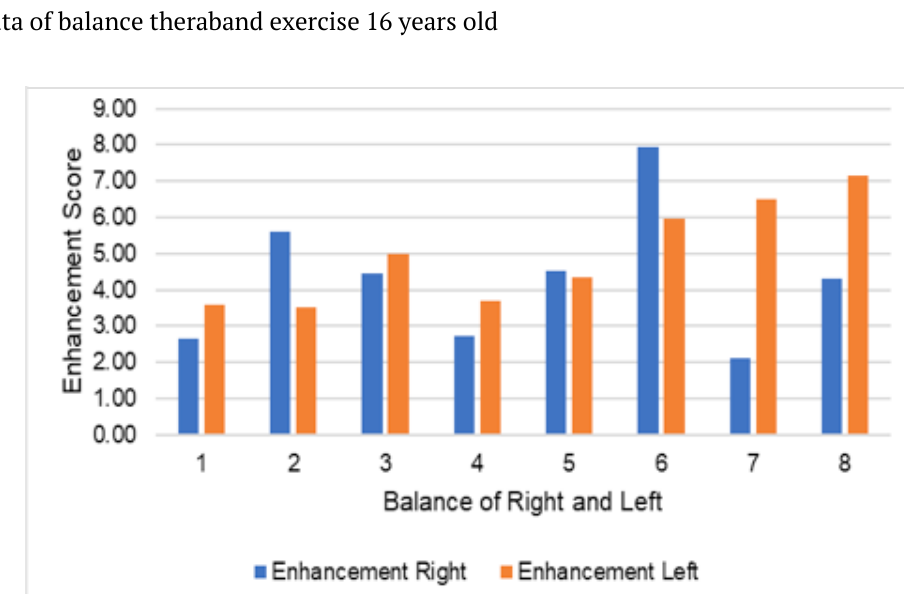
Figure 4. Enhancement of balance theraband exercise 16 years